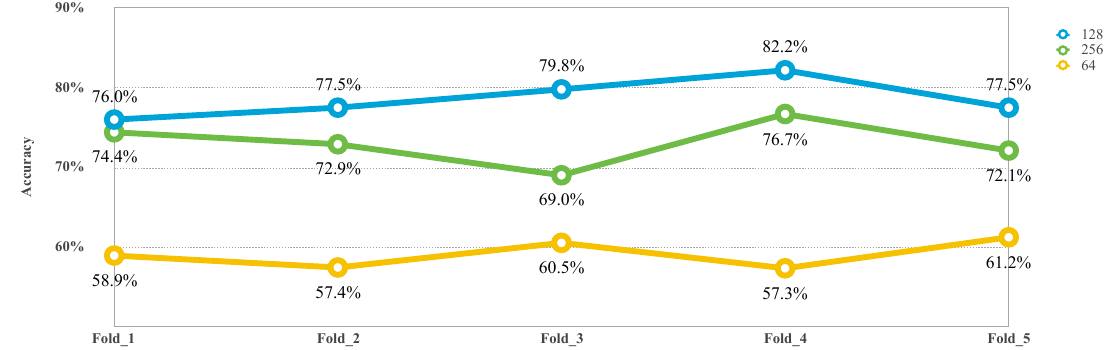
Figure 6. Accuracy with respect to varying the different number of convolutional kernels. The blue, green, and yellow lines represent 128, 256, and 64 kernels,